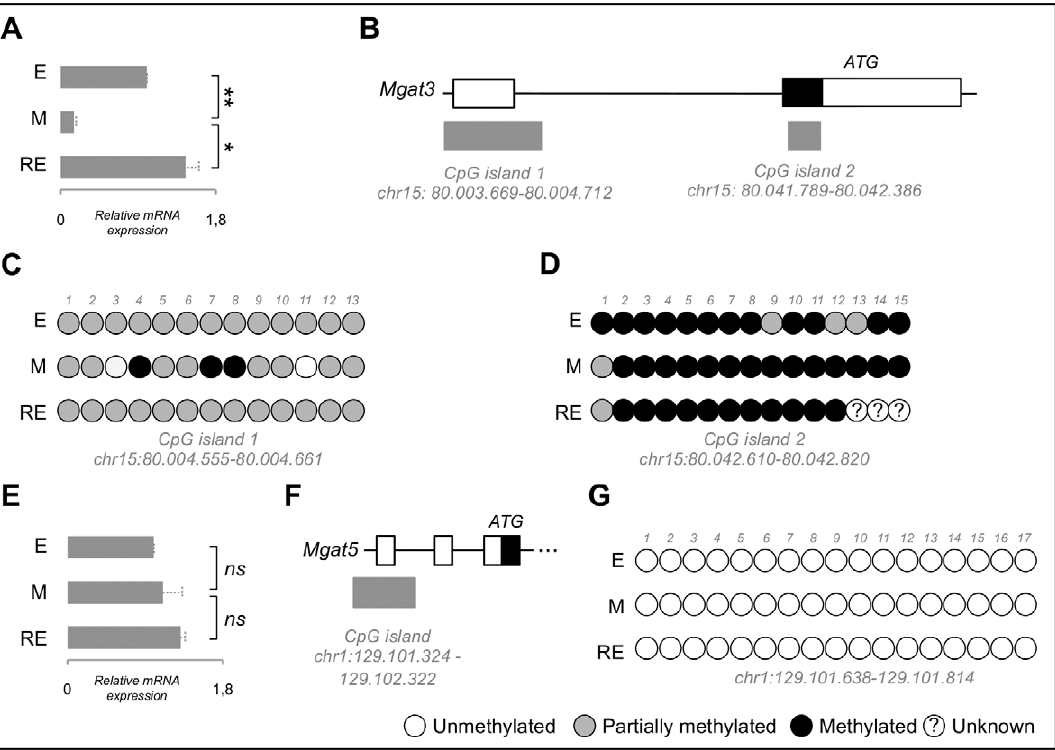
Figure 3. Mgat3 and Mgat5 RNA expression and methylation status of their predicted promoter-associated CpG islands. Panel A illustrates the quantification of Mgat3 relative mRNA expression ( n =3 biological replicas). Data was normalized for E cells for each biological replica. Single asterisk corresponds to p # 0.05 and double asterisks stands for p # 0.001. Results are described as mean 6 standard error mean of three biological replicas. Panel A shows that Mgat3 expression was significantly decreased in M cells (in comparison to E cells) and recovered in RE cells (in comparison to M cells). Schematic representation of Mgat3 genomic locus is represented in panel B. White squares correspond to exonic untranslated regions and black squares to exonic translated regions. Black line stands for intronic regions. Grey squares represent the position of the